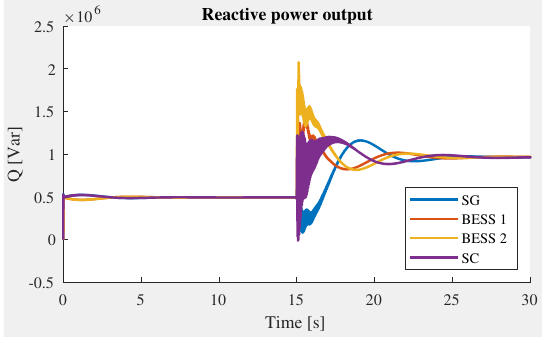
Figure 13. Reactive power output.